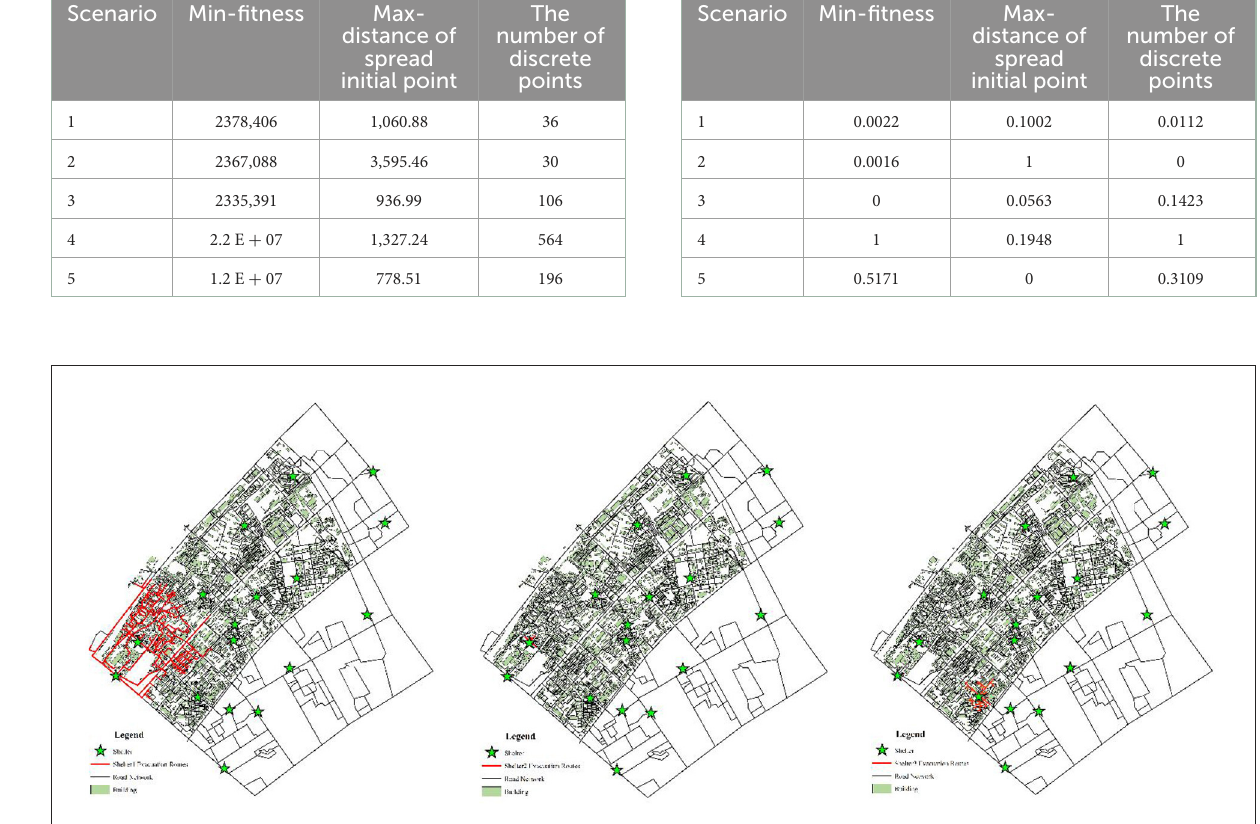
FIGURE11 Fitness iteration graph under different